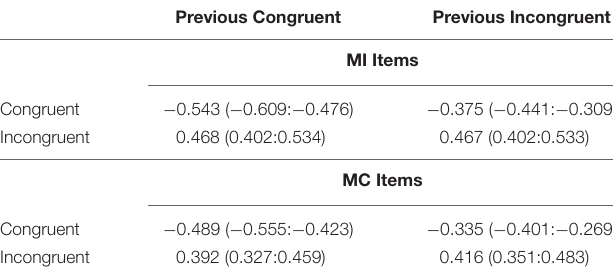
TABLE 5 | Mean z -scored RTs (and HDIs) in each condition for the CSE analysis of Experiment